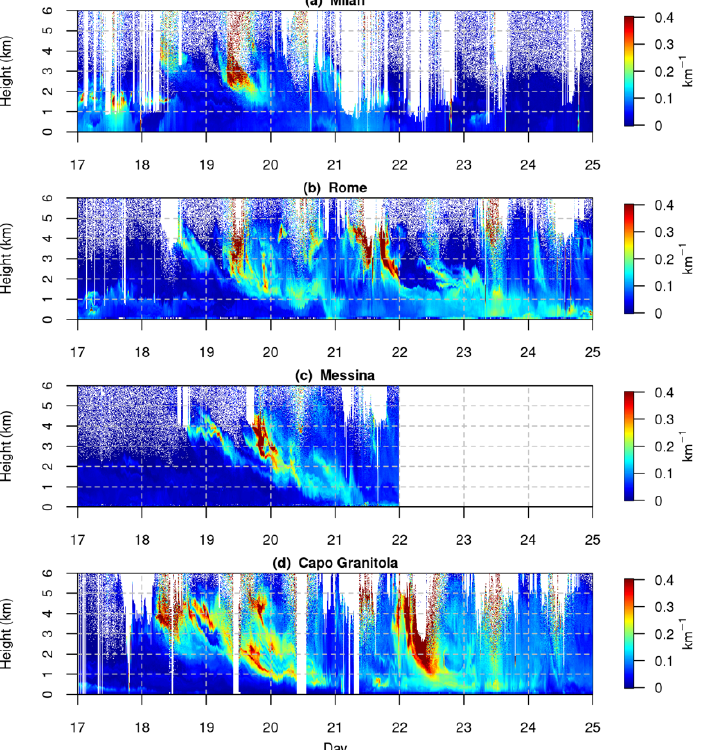
Figure 9. Continuous (h24) time series (17–24 June 2021, x -axis) of the vertically resolved (0–6 km, y -axis) aerosol extinction [at 1.064 µ m, (units km − 1 )] as derived from the four selected ALICENET ALC operating in ( a ) Milan, ( b ) Rome, ( c ) Messina and ( d ) Capo Granitola. Blank areas are cloud screened. The Messina ALC data are missing from 22 June due to power supply